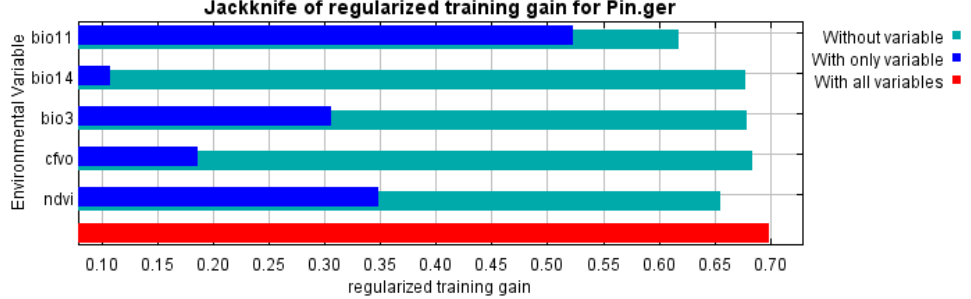
Figure 4. Jackknife test of regularized training gain contribution of the considered environmental variables and their importance for habitat suitability prediction of Pinus gerardiana . (For codes detail, please see Table 3).